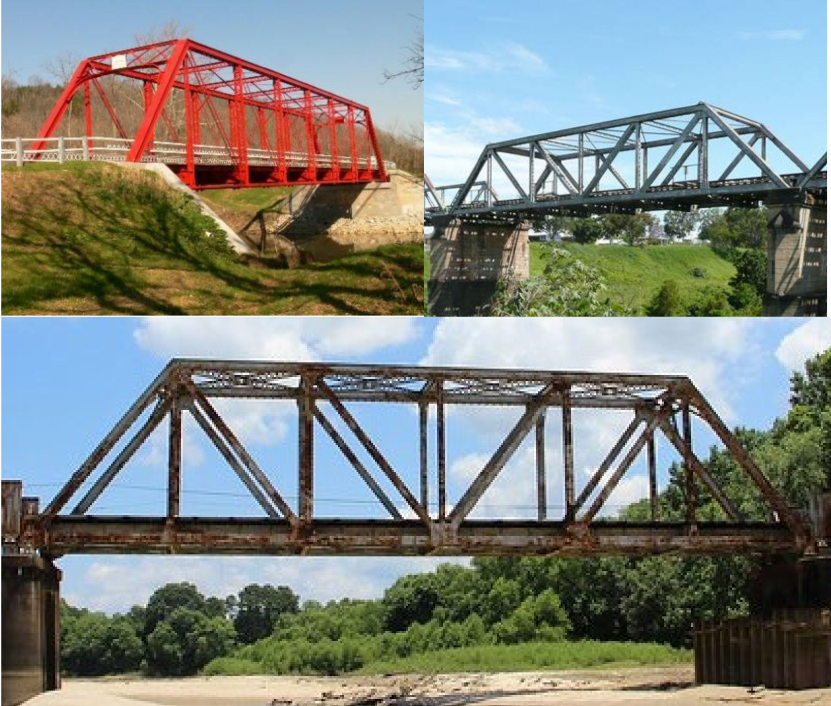
Figure 1. Road and railroad steel Pratt truss bridges (www.bridgehunter.com (26 January 2022)).